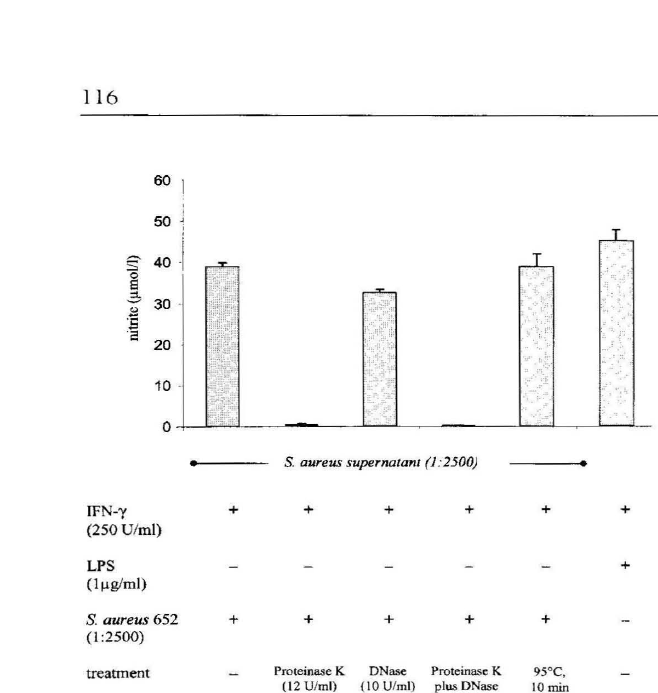
figure 3. Activity of supernatant from S. aureus patient isolate 652 to induce nitrite formation in RAW264.7 cells treated with 250 U/ml IFN-y for 3S h using DMEM/ FCS. Effects of treatment of supernatant with enzymes or heat are shown. D igestion with proteinase K( 14 mg/ml, Boehringer, Mannheim, Germany) or with OJ',;ase (RQ1 RNase-free DNase, Promcga, Madison, "W'l) were carried our t()r I h at 37"C.